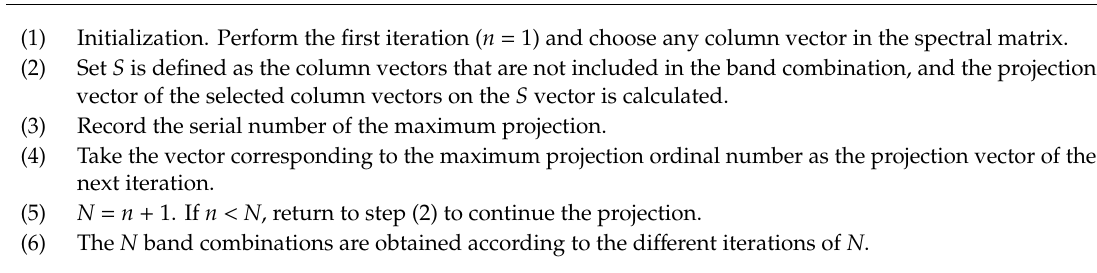
Table 1. Primary steps for performing the successive projections algorithm (SPA)-based dimensionality reduction